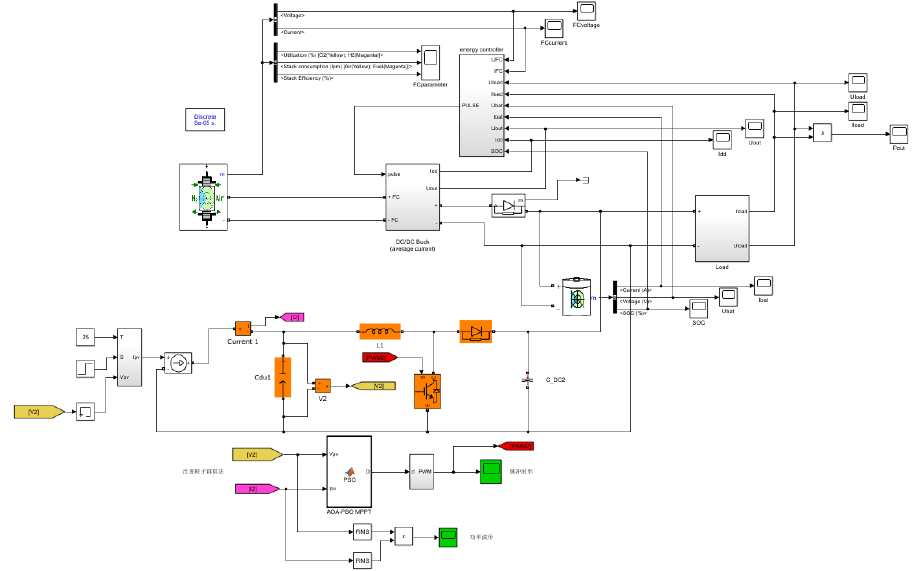
Figure 6. Overall simulation model of the photovoltaic hydrogen generation system.